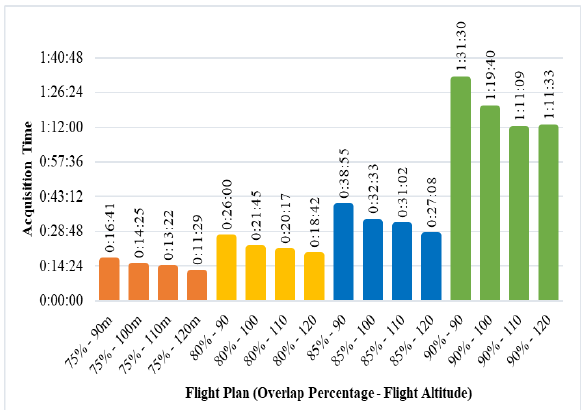
Figure 4 . Bar Graph for the visualization of flight plans based on acquisition time with respect to overlap percentage and flight altitude.